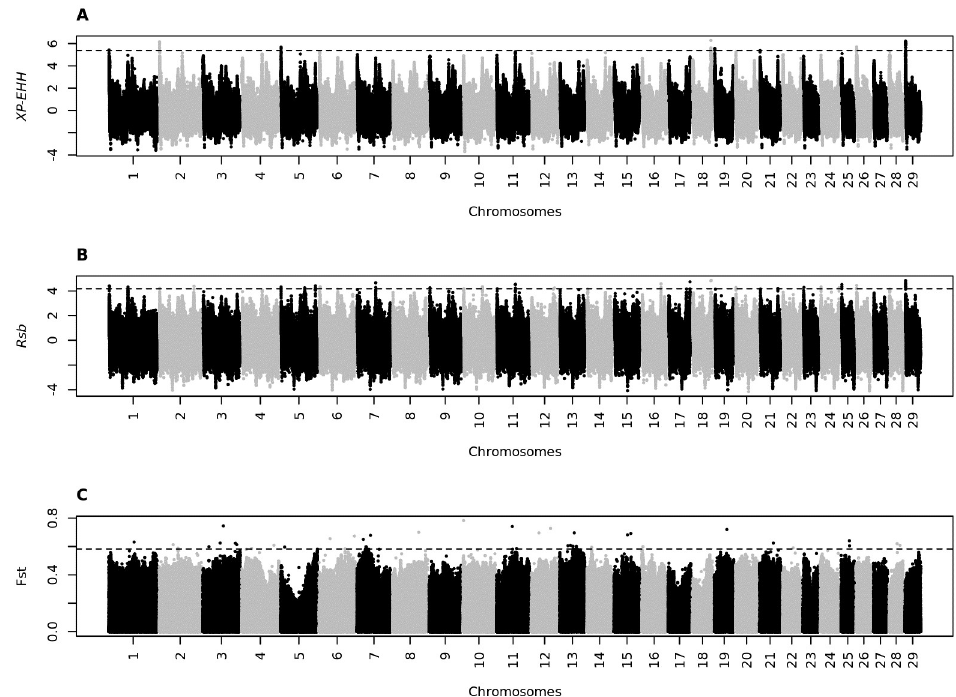
Fig 3. Manhattan plot for selection signature signals detected by the XP-EHH (A), Rsb (B), and Fst (C) methods for Canchim vs. Charolais.